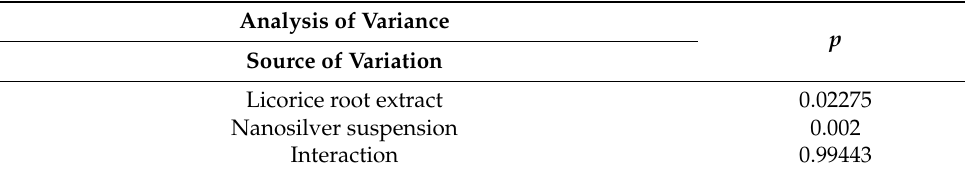
Table 2. Results of the statistical analysis of contact angle measurements performed via the two-way analysis of variance (ANOVA) ( p indicates the statistical significance).